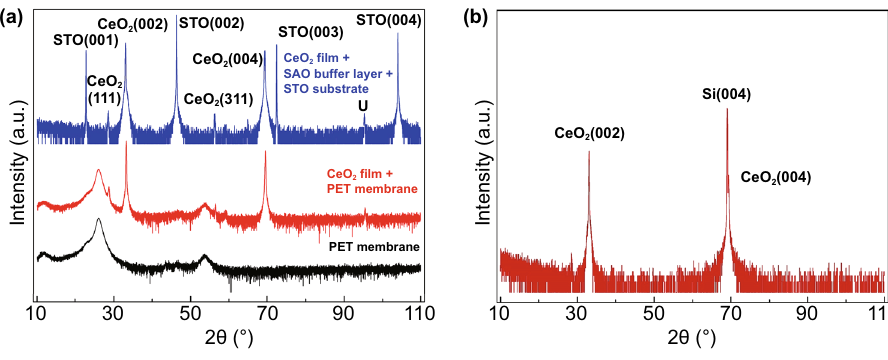
Fig. 6 X‑ray diffractograms (intensity on a log scale) for CeO 2 film grown on Sr 3 Al 2 O 6 buffer grown on SrTiO 3 in different stages of transfer onto PET membrane or Si. a XRD 2 θ – ω scan of CeO 2 film before transfer, CeO 2 film after transfer to PET, and blank PET membrane. U = uni‑ dentified peak. b XRD 2 θ – ω scan of CeO 2 film transferred to Si wafer